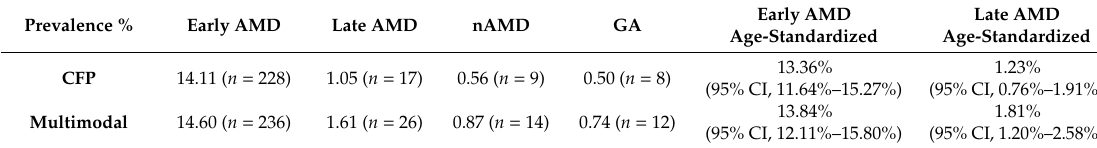
Table 4. Comparison of early and late AMD prevalence based in CFP versus multimodal